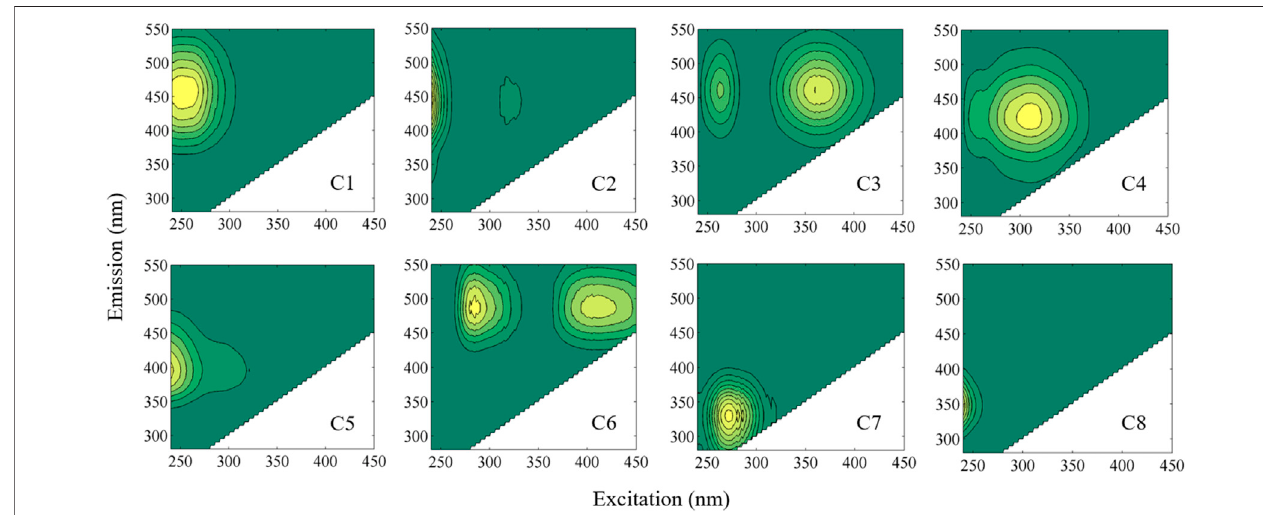
FIGURE 3 | Eight PARAFAC components used in this study. In speci fi c, C1 – C4 and C6 are classi fi ed as terrestrial humic-like components, and C5 as a microbial humic-like component. In addition, C7 is designated as a tryptophan-like component, and C8 is generally a protein-like component. The PARAFAC model has been validatedandcross-checkedwithotherpublishedstudies,showingnoover fi tting.FluorescenceintensitiesarenormalizedtoRamanunits(r.u.).Detailedinformationcan be found in Xue et al., 2022.